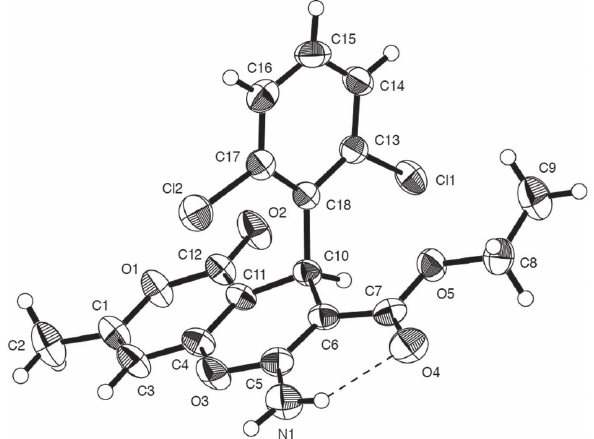
Table 2: Fractional atomic coordinates and isotropic or equivalent isotropic displacement parameters (Å 2